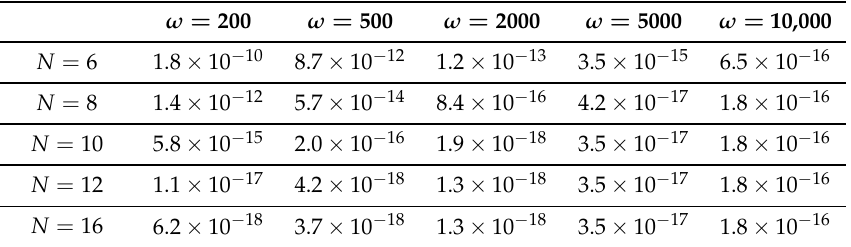
Table 4. Absolute errors of 2D-Cheb–Levin quadrature for Example